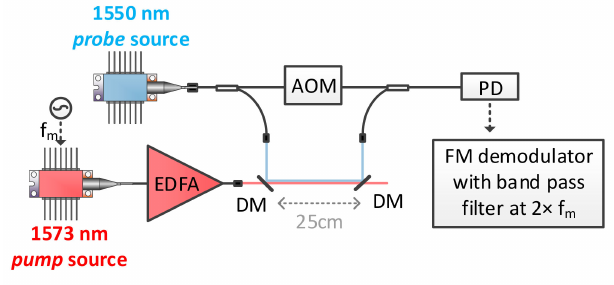
Figure 4. Schematic diagram of PAS measurement using a 2 µ m tunable fiber laser as the pump source, and a Mach-Zehnder fiber interferometer at 1.55 µ m for path-length modulation signal retrieval. TDFA—thulium doped fiber amplifier, DM—dichroic mirror, AOM—acousto-optical